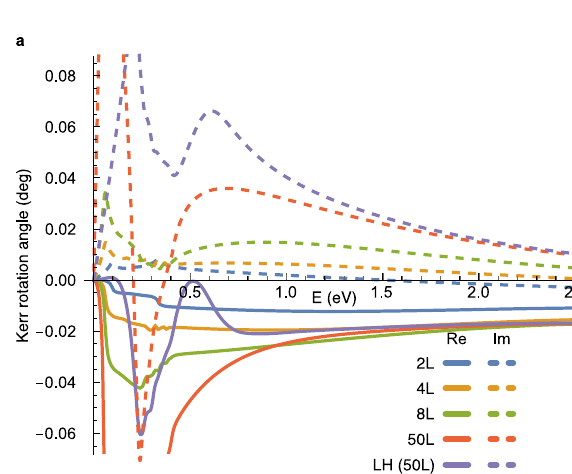
Fig.5|KerrandFaradayrotationanglesinthelow-energytight-bindingmodel of MnBi 2 Te 4 . a Complex Kerr rotation angle ϕ K =tan (cid:1) 1 ð r xy = r xx Þ . b Complex Fara- day rotationangle ϕ F =tan (cid:1) 1 ð t xy = t xx Þ . Therealand imaginary parts of the complex angles are shown as solid and dashed lines, respectively. We consider the effect of bothtop andbottom surfacesbyusing Eqs.(15)and (16)withtherefractive indices n 1 =2.2 and n 3 =2.4 for the capsulating media. The complex refractive index ofthe